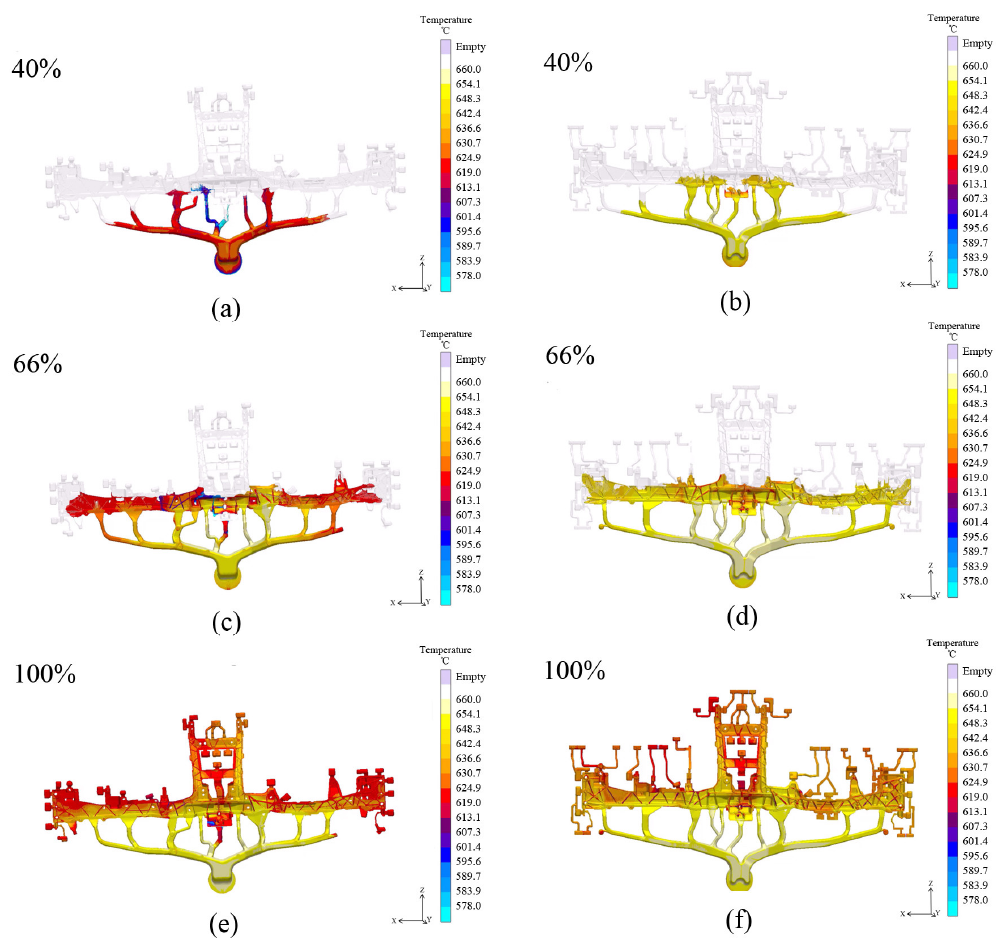
Figure 2. Temperature distribution diagram of two projects: scheme1 ( a , c , e ); scheme 2 ( b , d , f ).